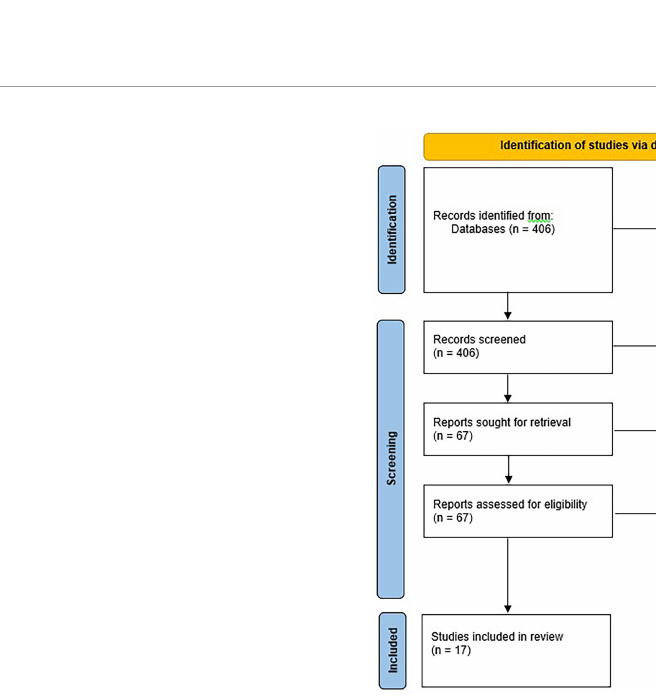
FIGURE 2 | Median overall survival after radiosurgery: 10 months in the 5-9 brain metastases group vs 15.7 months in the 10-15 brain metastases